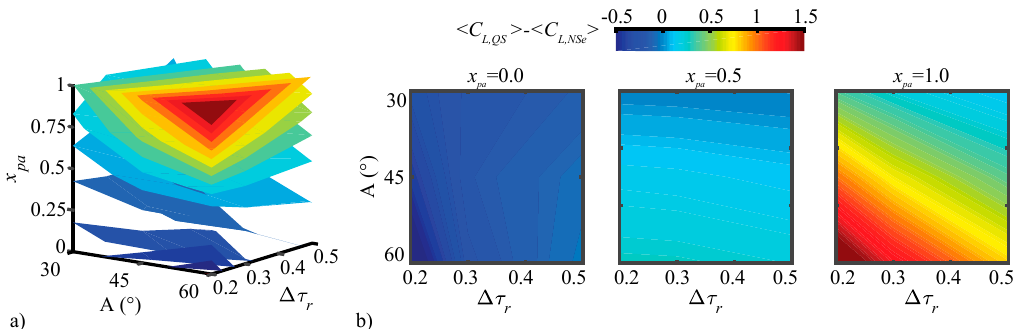
Figure 12. Contour plots of the differences in cycle-averaged lift coefficient between QS and NSe (< C L , QS > − < C L , NSe >) in the design space of the pitching axis ( x pa ), pitching duration ( Δ τ r ), and pitching amplitude (A). ( a ) Iso-surfaces of < C L , QS > − < C L , NSe > in the design space. ( b ) Slices of < C L , QS > − < C L , NSe > in the design space at various x pa .